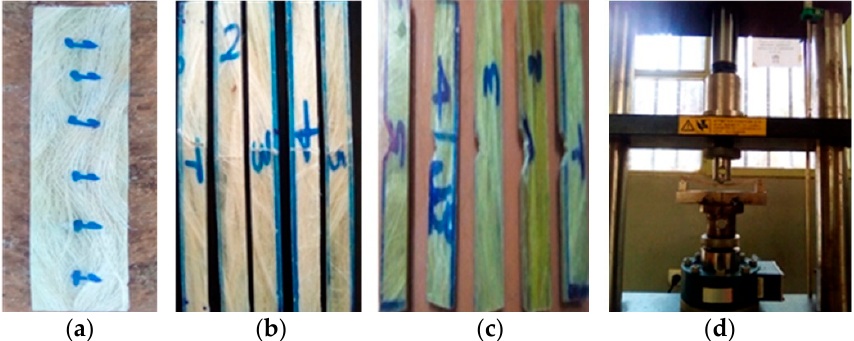
Figure 2. ( a ) Tensile, ( b ) flexural, ( c ) impact test specimen and ( d )